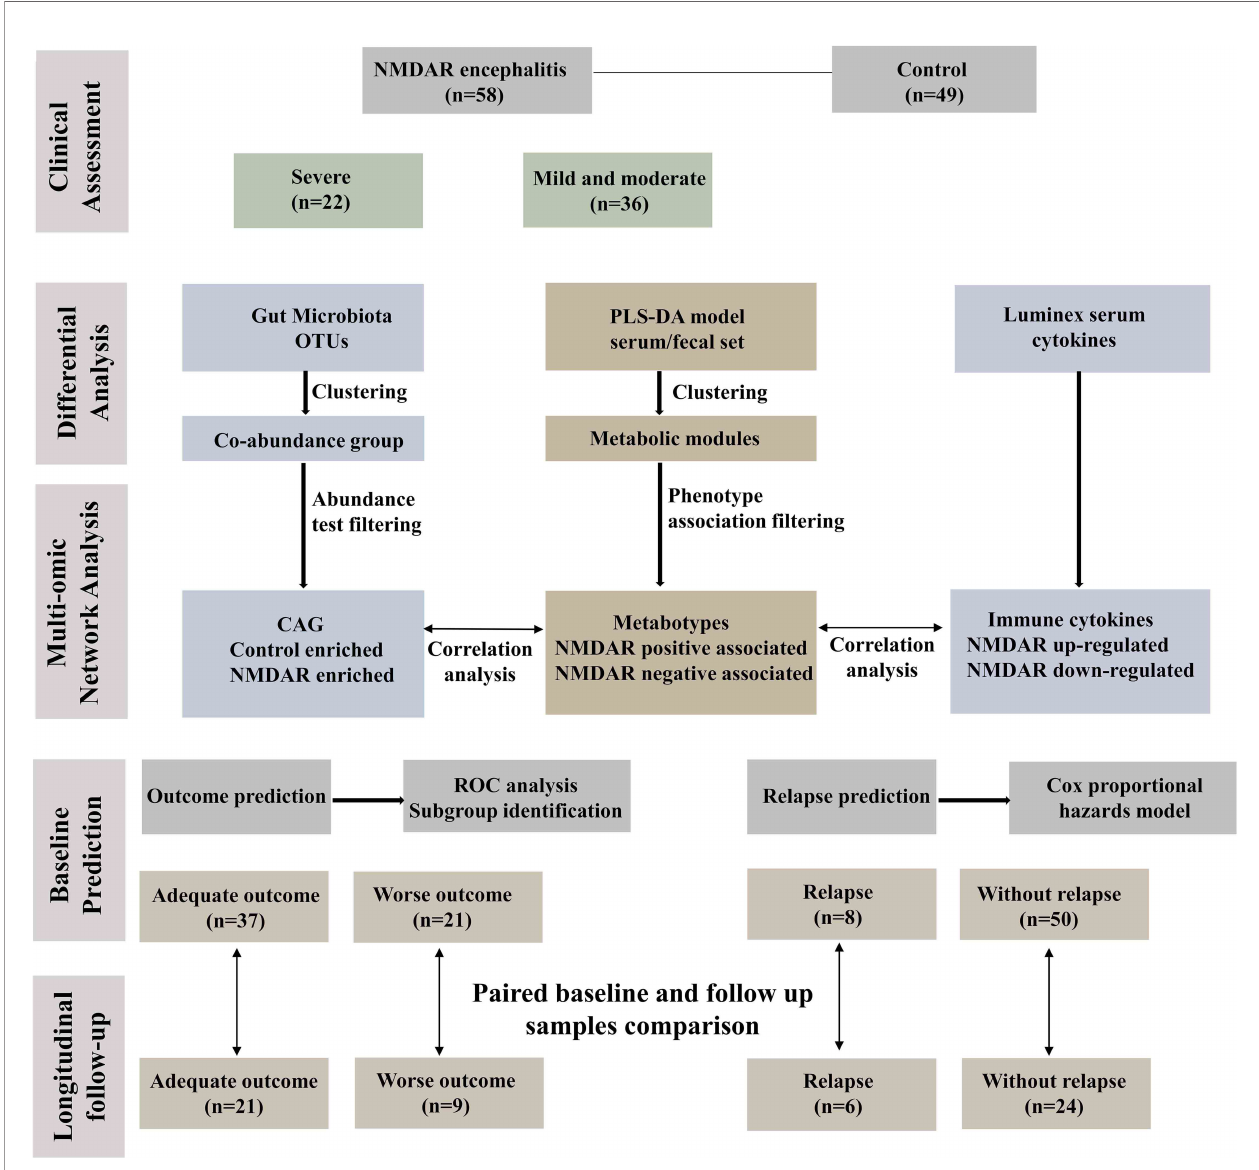
FIGURE 1 | Work fl ow integrating anti- N -methyl- D -aspartate receptor (NMDAR) encephalitis gut microbiome, fecal and serum metabolomes, and cytokines. Fifty- eight patients with a de fi nite diagnosis of NMDAR encephalitis were divided into different severity groups: severe ( n = 22) and moderate ( n = 36); there were 49 healthy controls. We next constructed a co-abundance network with 294 operational taxonomic units (OTUs) and clustered them into 19 co-abundance groups (CAGs). Subsequently, we identi fi ed the important CAGs that were strikingly prevalent in patients with more severe status. We then identi fi ed the serum and fecal metabolome and cytokine features between NMDAR encephalitis patients and healthy controls. Serum and fecal metabolites were summarized as co-abundance metabolic modules. Next, we identi fi ed the relationships between the markedly altered gut microbiome composition, host metabolic pro fi les, and the major dysregulated cytokines. Finally, fecal and serum samples from 30 patients after 6 months offollow-up were collected to investigate longitudinal deviations in dysbiosis and establish associations between disease outcome markers and